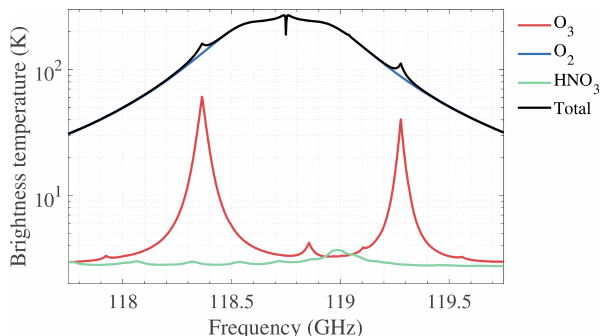
Figure 4. Contributions of the main target chemical species to the 118GHz spectrum. The brightness temperature is measured from the single-sideband radiometer. The tangent height is